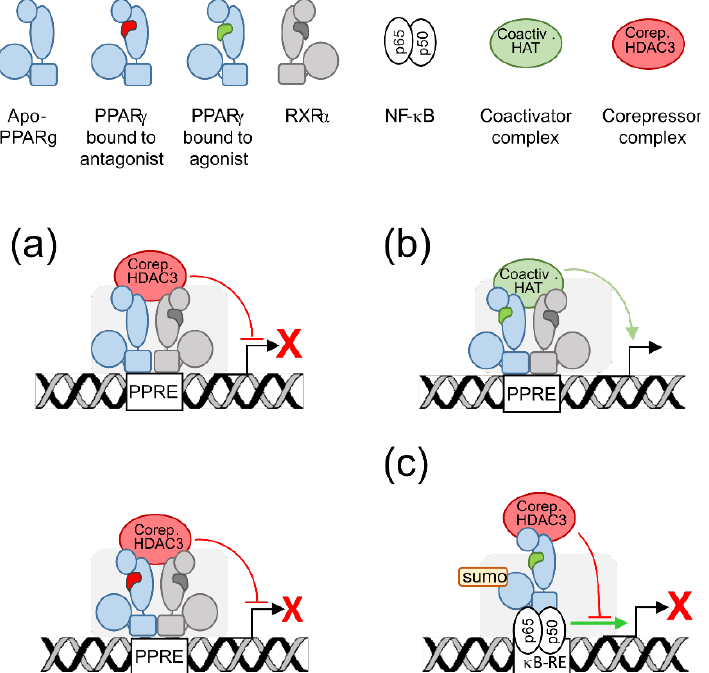
Figure 1. Graphical summary of PPARγ transactivating and transrepressing activities. ( a ) DNA binding- dependent transrepression: unbound PPARγ (top) or PPARγ bound to an antagonist (bottom) forms a dimer with RXRα, binds to a cognate response element (PPRE) and recruits corepressors (Corep.) and HDAC3 to assemble a repressive complex which blocks transcription of the cognate gene (broken arrow). ( b ) Transactivation: agonist- bound PPARγ and RXRα, bound to a PPRE, recruit coactivators (Coactiv.) and HAT to assemble a permissive complex which enhances transcription of the cognate gene. ( c ) DNA binding-independent transrepression: ligand-activated PPARγ and corepressor complex bind to a target transcription factor as NF - ĸ B to prevent it from activating cognate gene transcription. Sumoylation (sumo) increases the stability of the complex PPARγ -corepressor. ĸ B-RE: NF- ĸ B response element.